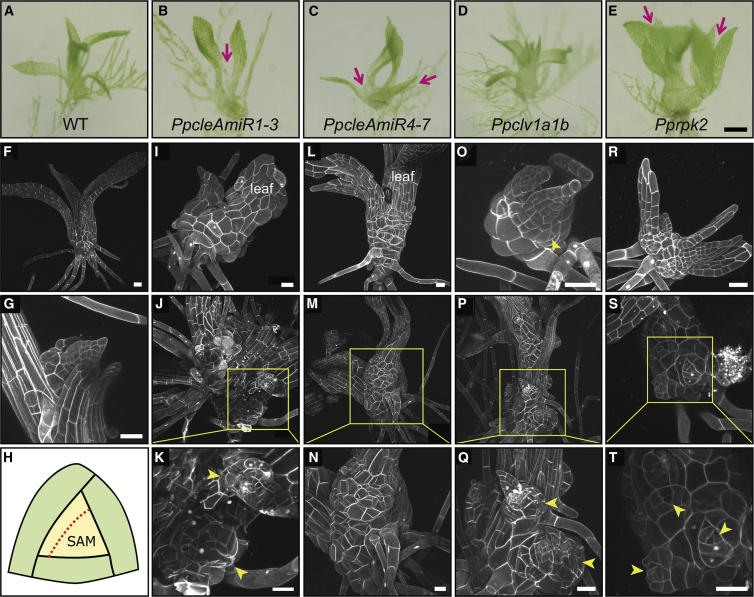
Overproliferation Phenotypes in PpAmiRcle, Ppclv1, and Pprpk2 Mutants(A–E) Light micrographs of mutant gametophore morphology showing that gametophores (B) arrest, (C and E) develop multiple axes (pink arrows), and (C–E) develop swollen bases relative to (A) WT plants. The scale bar represents 200 μm.(F and G) Confocal micrographs showing (F) overall gametophore morphology and (G) a branch initiating in a leaf axil in WT plants.(H) Schematic showing Physcomitrella gametophore apex organization with an apical cell (pale yellow) and rotating division plane orientations.(I–T) Confocal micrographs showing (I–K) PpcleAmiR1-3 mutant gametophore morphologies, with (I) overproliferation at the gametophore base and (J and K) disorganized growth with ectopic meristems.(L–N) PpcleAmiR4-7 mutant gametophore morphologies with (L) split leaf phenotypes and (M and N) meristem overproliferation and termination.(O–Q) Ppclv1a1b mutant gametophore morphology (O), with multiple growth axes and multiple meristems at the gametophore base (P and Q).(R–T) Pprpk2 mutant gametophore morphology with multiple growth axes (R) and multiple meristems at the gametophore base (S and T).Yellow arrowheads indicate regions of overproliferation or ectopic meristems. Yellow boxes show regions magnified from (J), (M), (P), and (S) to (K), (N), (Q), and (T). The scale bars represent 50 μm.